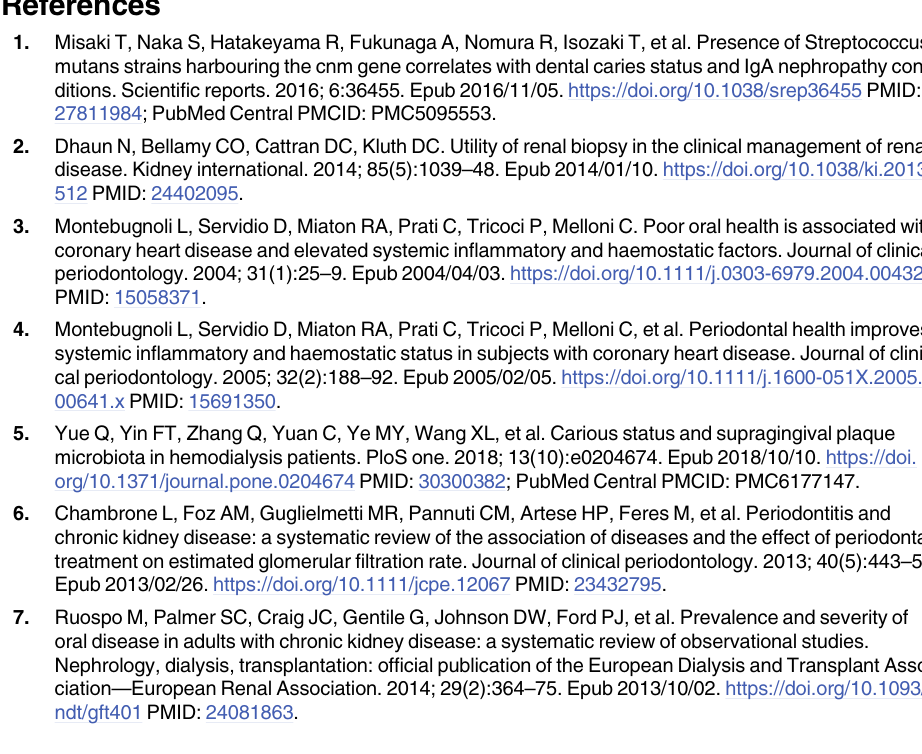
S4 Table. Association between anamnesis of a history of heart disease and high DMFT index score in patients on